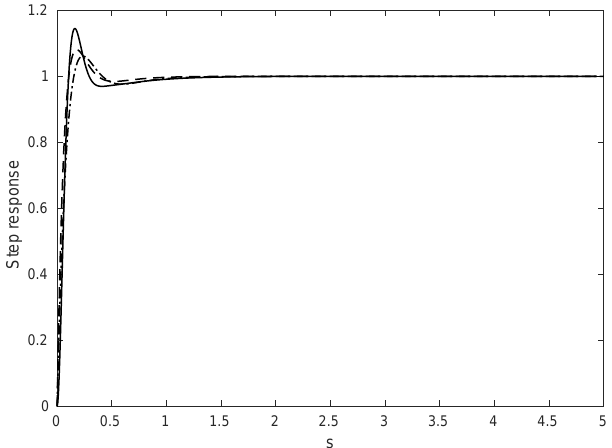
Figure 2. PID time responses to a unit step input for V f and V l (dashed line), Ψ (dash-dot line) and z (solid line). All PID controllers reach steady state within 1